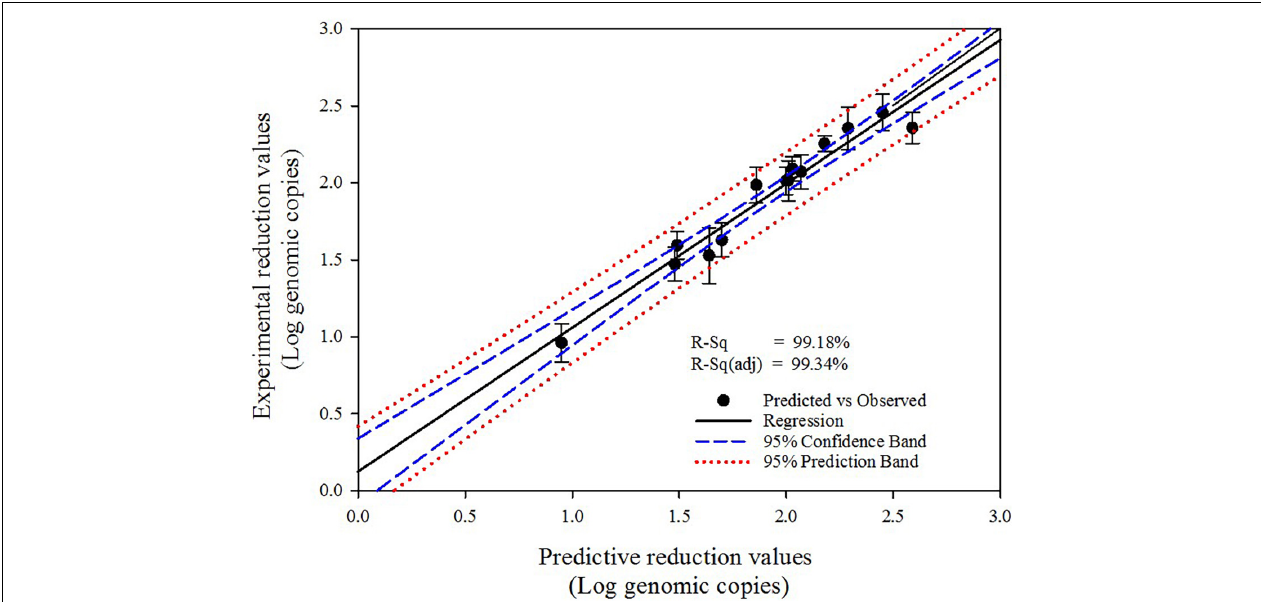
FIGURE 2 | Fitted line plot presenting experimental and predicted values for the inactivation of human norovirus (HuNoV).